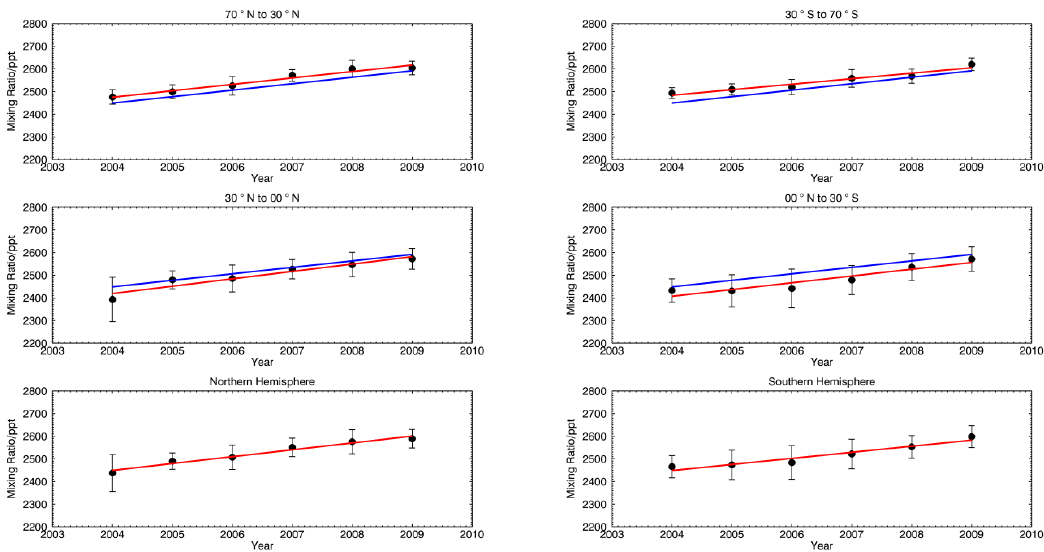
Figure 4: The trends in the mean total stratospheric fluorine (ppt) between 2004 and 2009. The red line represents the line of best fit for the mean stratospheric total fluorine volume mixing ratio (the black circles). The blue line is the global trend in mean total stratospheric fluorine. The error bars shown in the plots are the standard deviation of the data used to calculate the mean total fluorine VMRs.